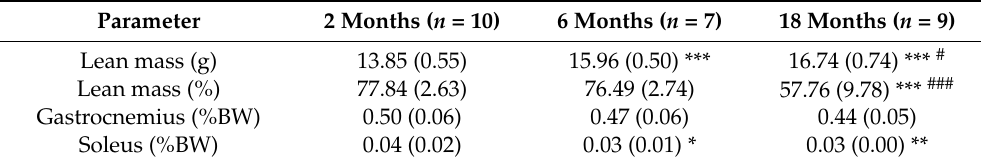
Table 2. Whole-body lean mass and gastrocnemius and soleus relative weights in young (2 months), adult (6 months) and old (18 months)